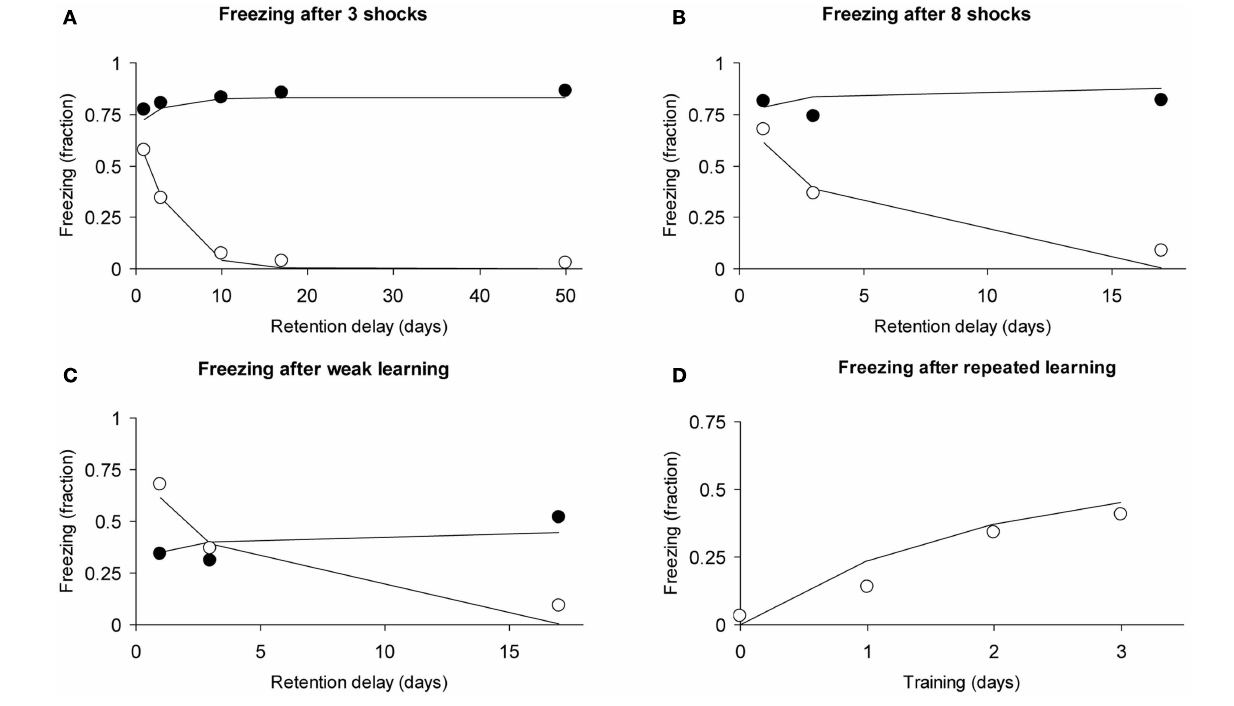
FIGURE 9 | Observed freezing data (circles) and predicted data (lines) of the study by Frankland et al. (2001) using the assumption of zero consolidation in the experimental condition (see text). Open circles refer to experimental subjects (mice), closed circles to controls. (A) Forgetting curves after learning with three foot shocks. (B) Forgetting